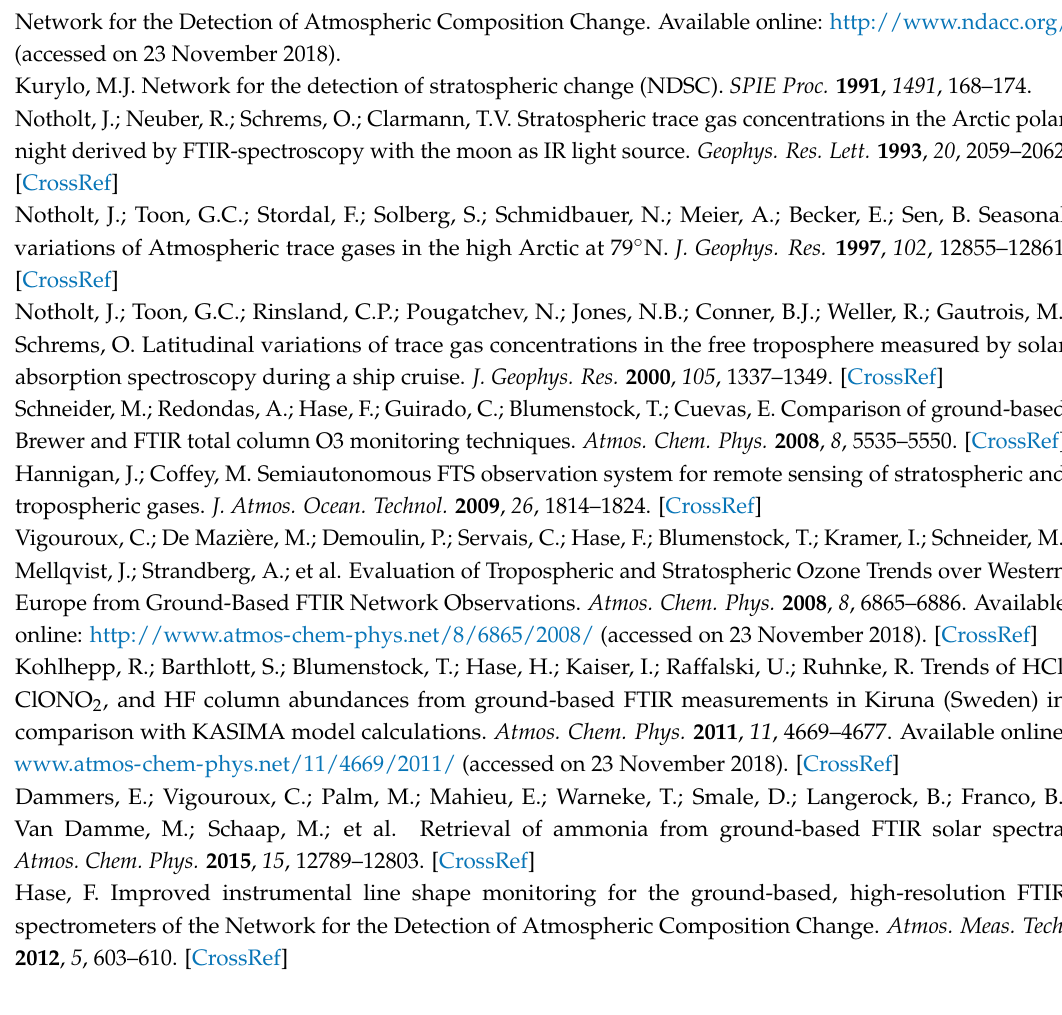
Figure S7: The same as Figure S6 but for CO; Figure S8: The same as Figure S6 but for CH 4 ; Figure S9: The same as Figure S6 but for N 2 O; Figure S10: The same as S6 but for a maximum ME deviation of − 4%; Figure S11: The same as S7 but for a maximum ME deviation of − 4%; Figure S12: The same as S8 but for a maximum ME deviation of − 4%; Figure S13: The same as S9 but for a maximum ME deviation of −